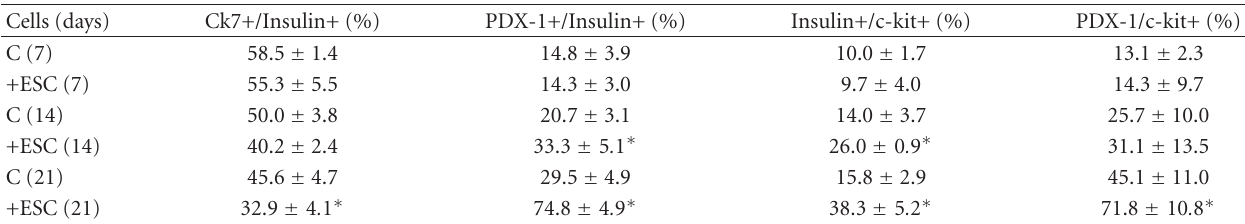
Table 2: Immunohistochemical analysis of di ff erentiation markers of NPI monolayers cultured alone or in the presence of